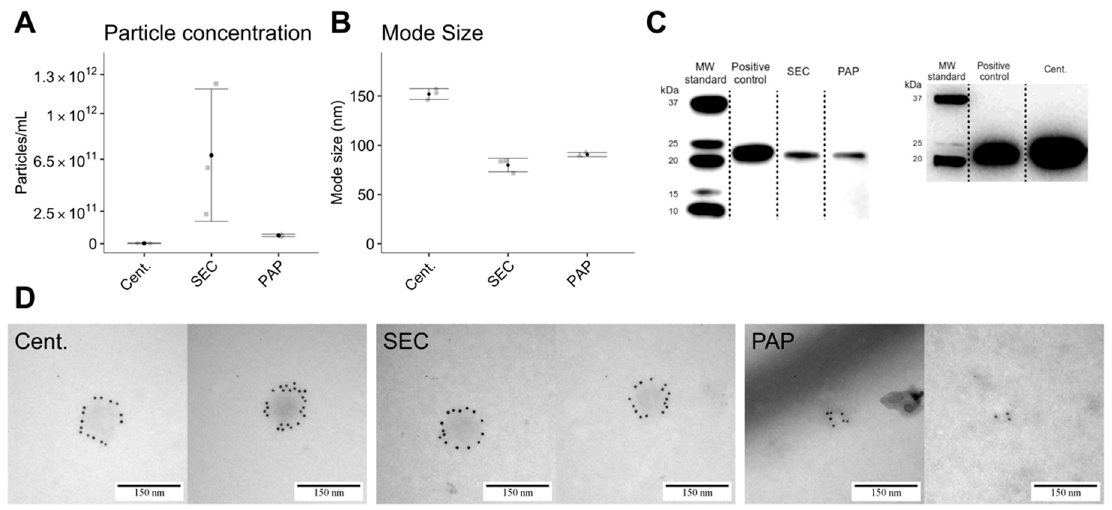
Figure 2. EV characterization by nanoparticle tracking analysis (NTA), immunoblotting, and transmission electron microscopy (TEM). ( A ) Differences in particle concentration measured by NTA. ( B ) Differences in particle mode size measured by NTA. ( C ) Immunoblot against CD9 (24 kDa) confirming the presence of the EV specific protein CD9 in isolates from all methods. ( D ) TEM images showing CD9 expression in vesicle-like particles in all three isolation methods. Error bars: Mean ± SD.